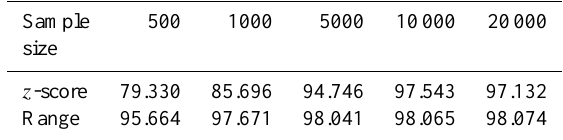
Table 3. Performance of the Ward linkage for varying sample